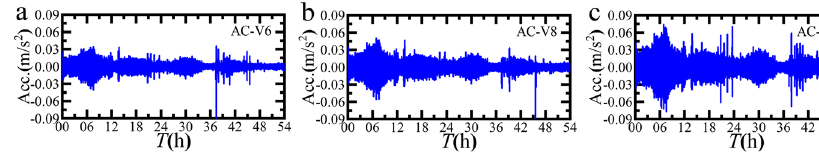
Fig. 7 Acceleration responses at three PSRB observation points: a AC-V6; b AC-V8; c AC-V10